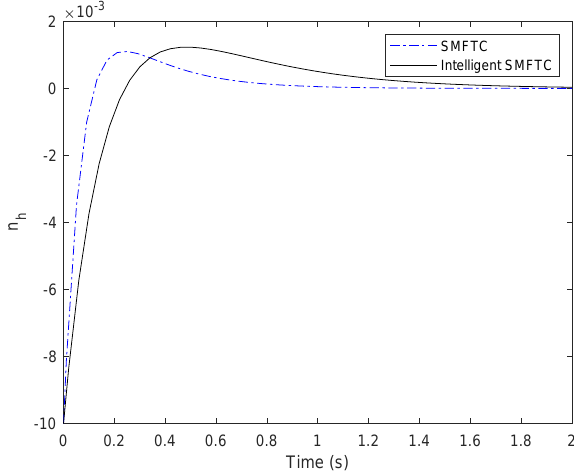
Figure 17. Normalized deviation speed of high-pressure spool.